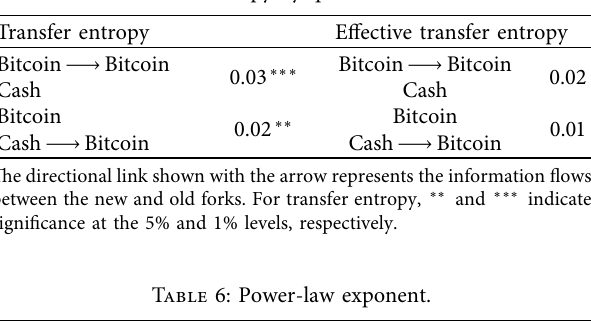
Table 5: Transfer entropy by quantile-based